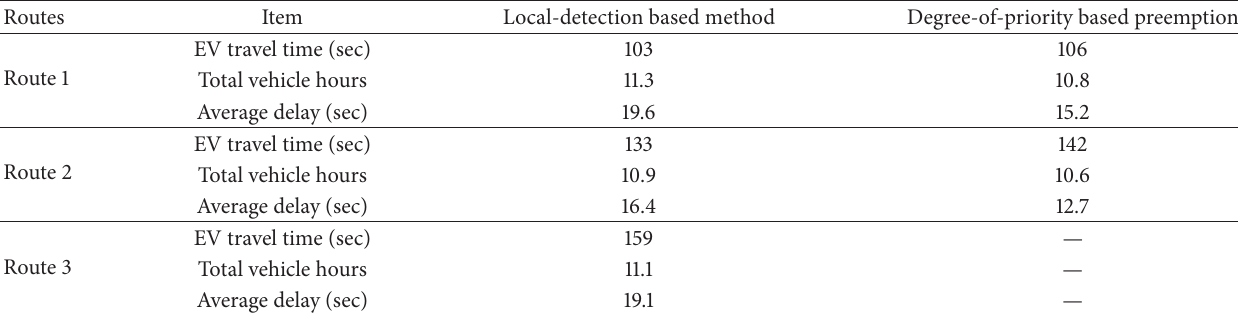
Table 6: Simulation results from different preemption